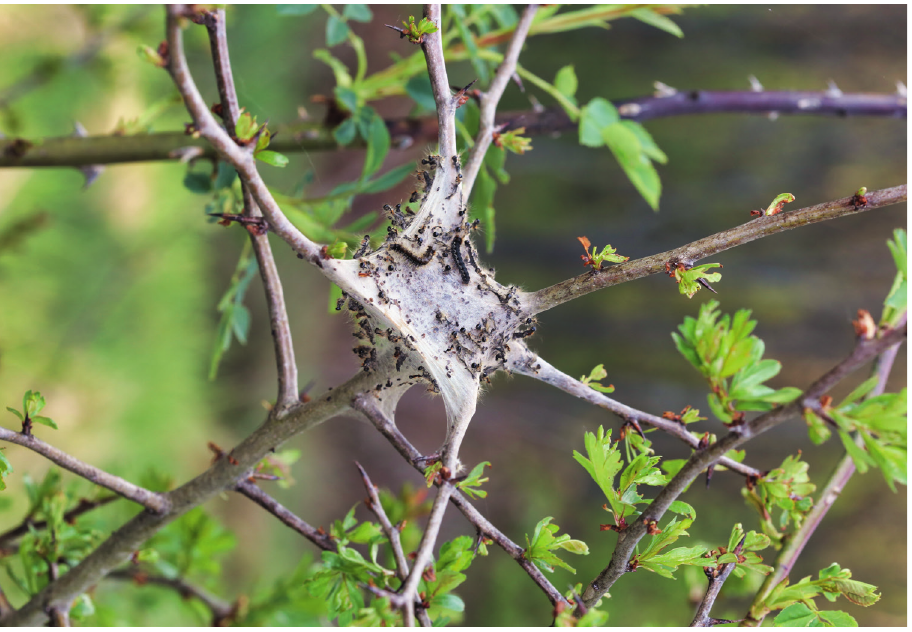
Figure 3. Eriogaster catax ,